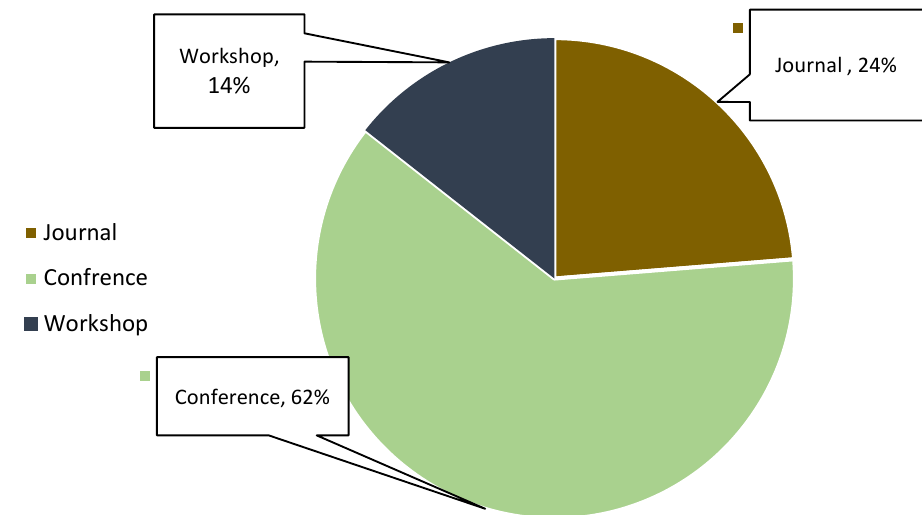
Figure 4. Percentage of journal, conference, and workshop papers included in the